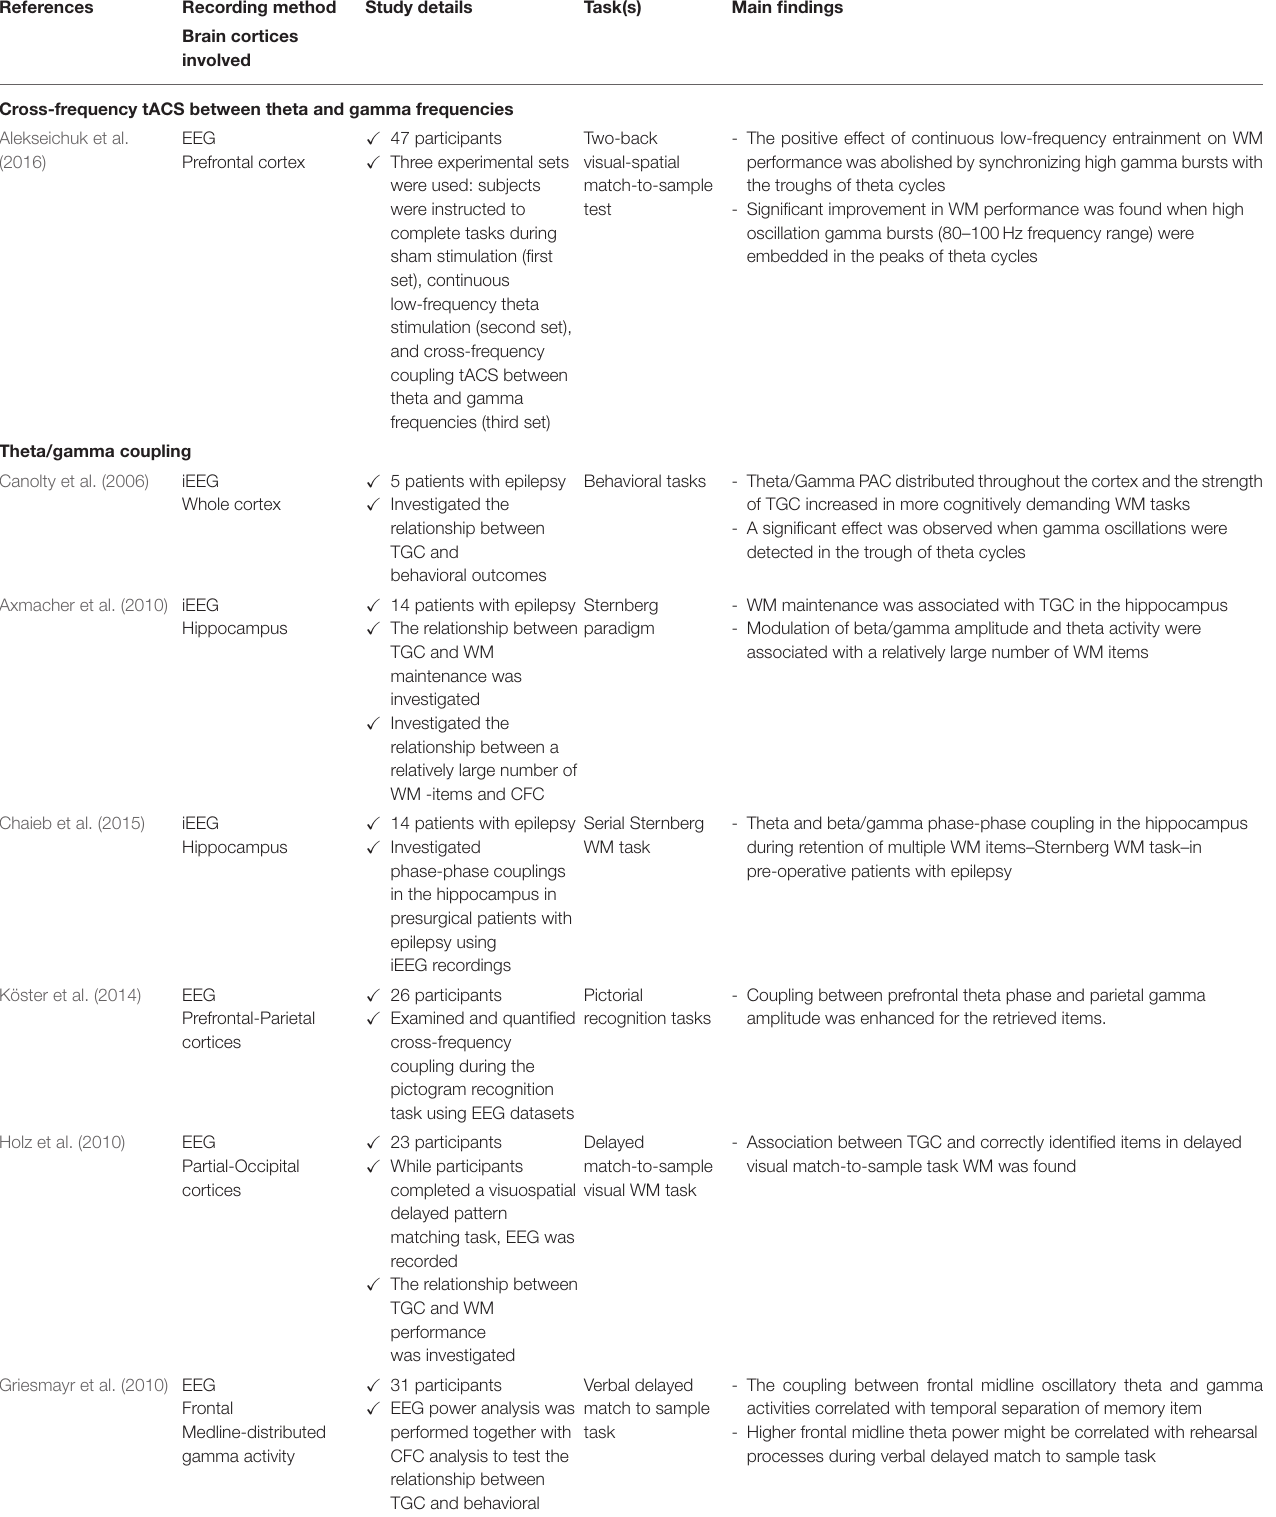
TABLE 1 | Studies that investigated the association between the cross-frequency coupling (CFC) over different brain cortices and working memory (WM)